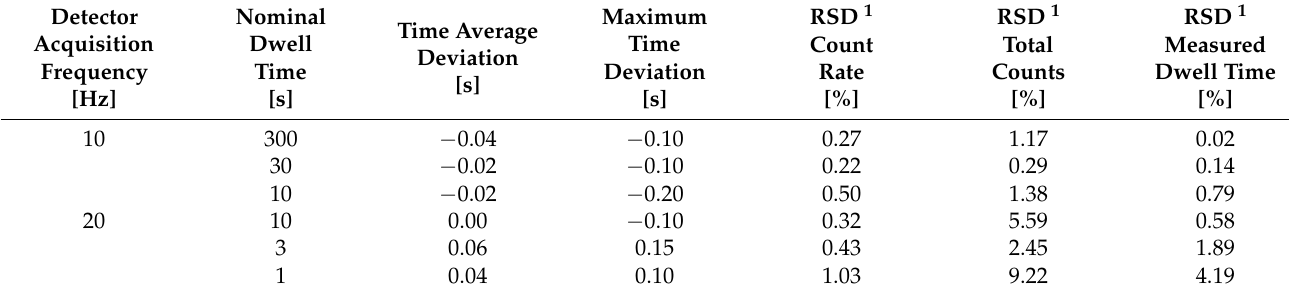
Table 1. Summary of the results of the repeatability